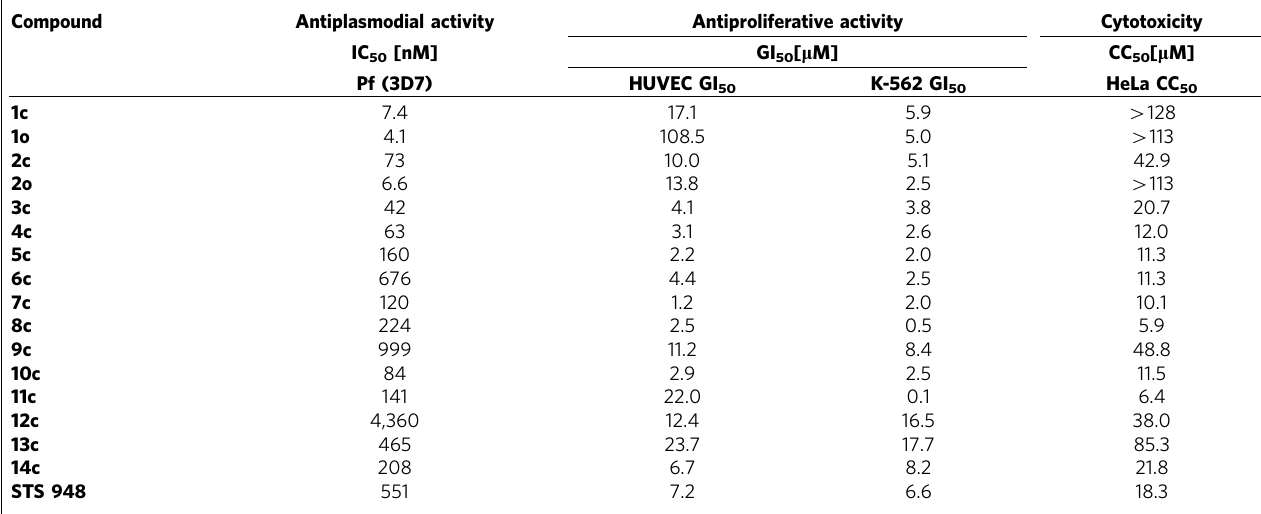
Table 1 | Antiplasmodial effects as well as antiproliferative and cytotoxic activity of selected steroid compounds on mammalian cells. Compound